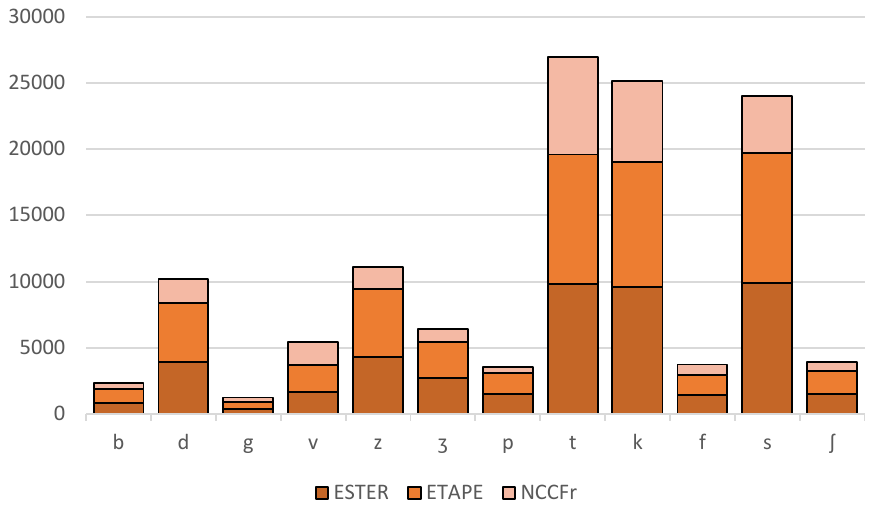
Figure 1. Number of tokens for each coda in each